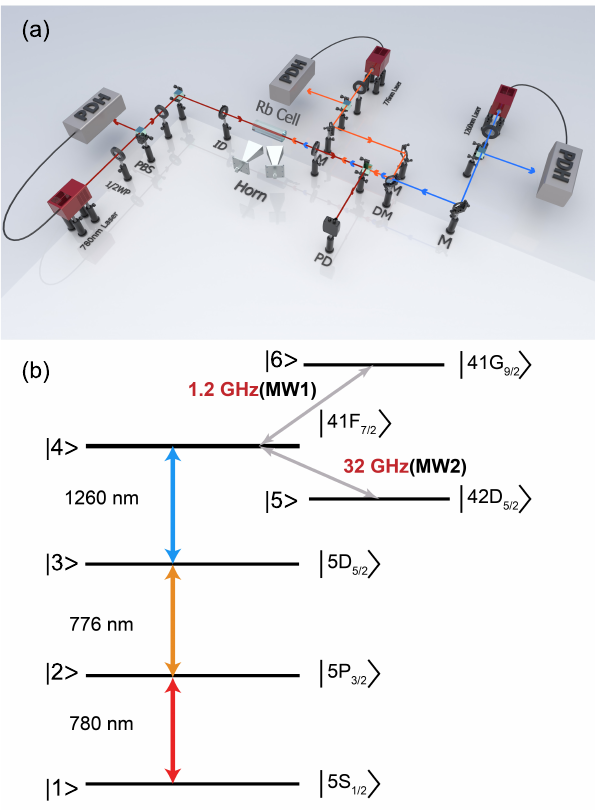
Figure 1. ( a ) Experimental schematic setup of the three infrared laser driven Rb Rydberg-based MW receiver and ( b ) relevant energy levels diagram. All infrared lights are generated by external cavity semiconductor lasers and frequency-stabilized by PDH system with the ultra stable Fabry–Perot cavity. The Rb atoms in vapor cell are excited successively to the 41F 7/2 Rydberg state by 780 nm, 776 nm, 1260 nm lasers, which is also coupled with MW1 on the transition 41F 7/2 ↔ 41G 9/2 and MW2 on neighboring transition 41F 7/2 ↔ 42D 5/2 , as shown in underlying figure. The terminology in the upper figure about optical components: λ /2-WP is acronym of a half-wave plate; PBS is polarization beam splitter; ID is iris diaphragms; PD is photodetector; DM is dichroic mirror and M